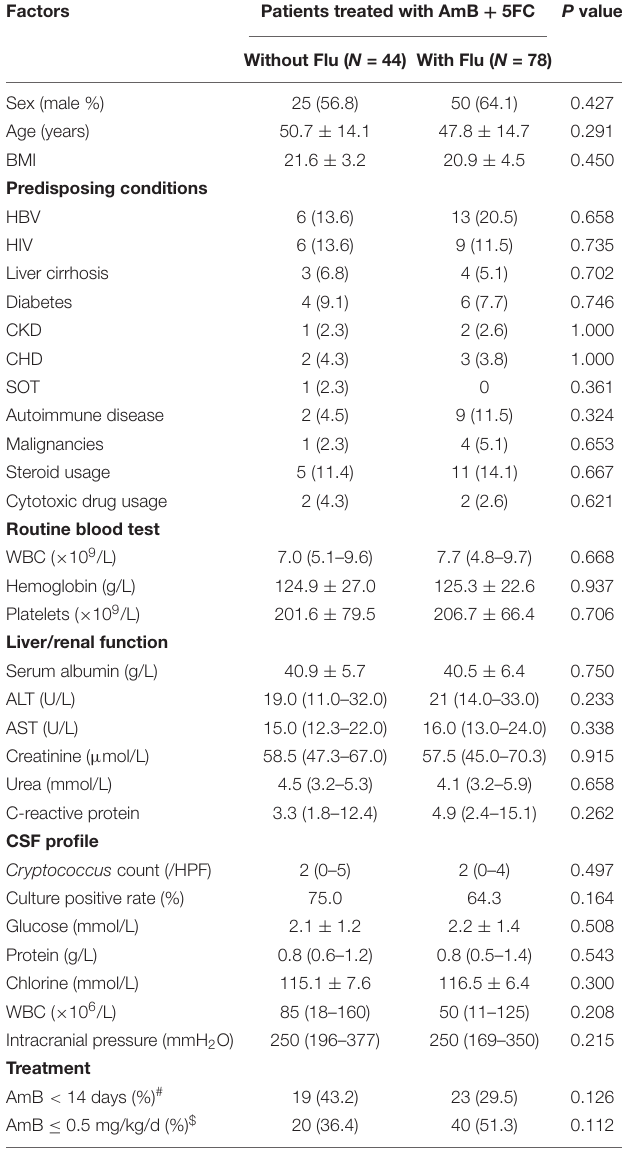
TABLE 1 | Comparisons of the clinical features of CM patients treated with AmB + 5FC and those treated with AmB + 5FC + Flu. Factors Patients treated with AmB +